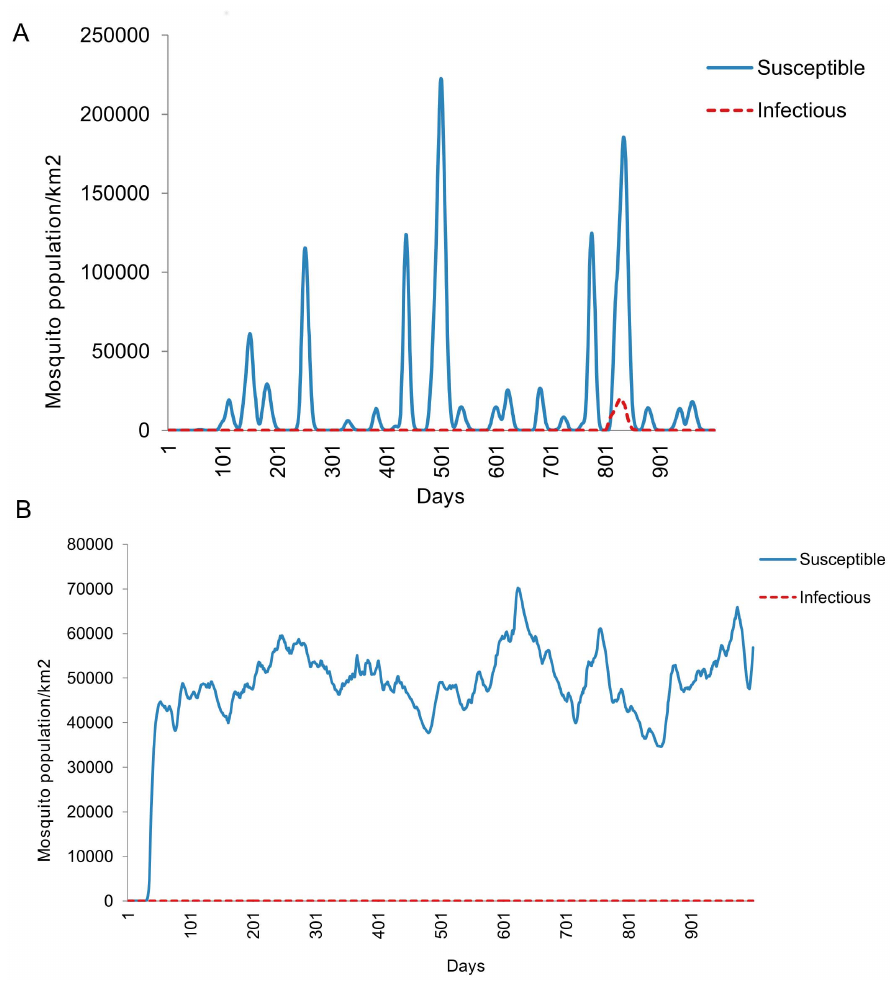
Figure 4. Simulated infection initiation before virus amplification. (A) Floodwater Aedines initiate infection. (B) Culicines without infection from infected sheep to prevent virus